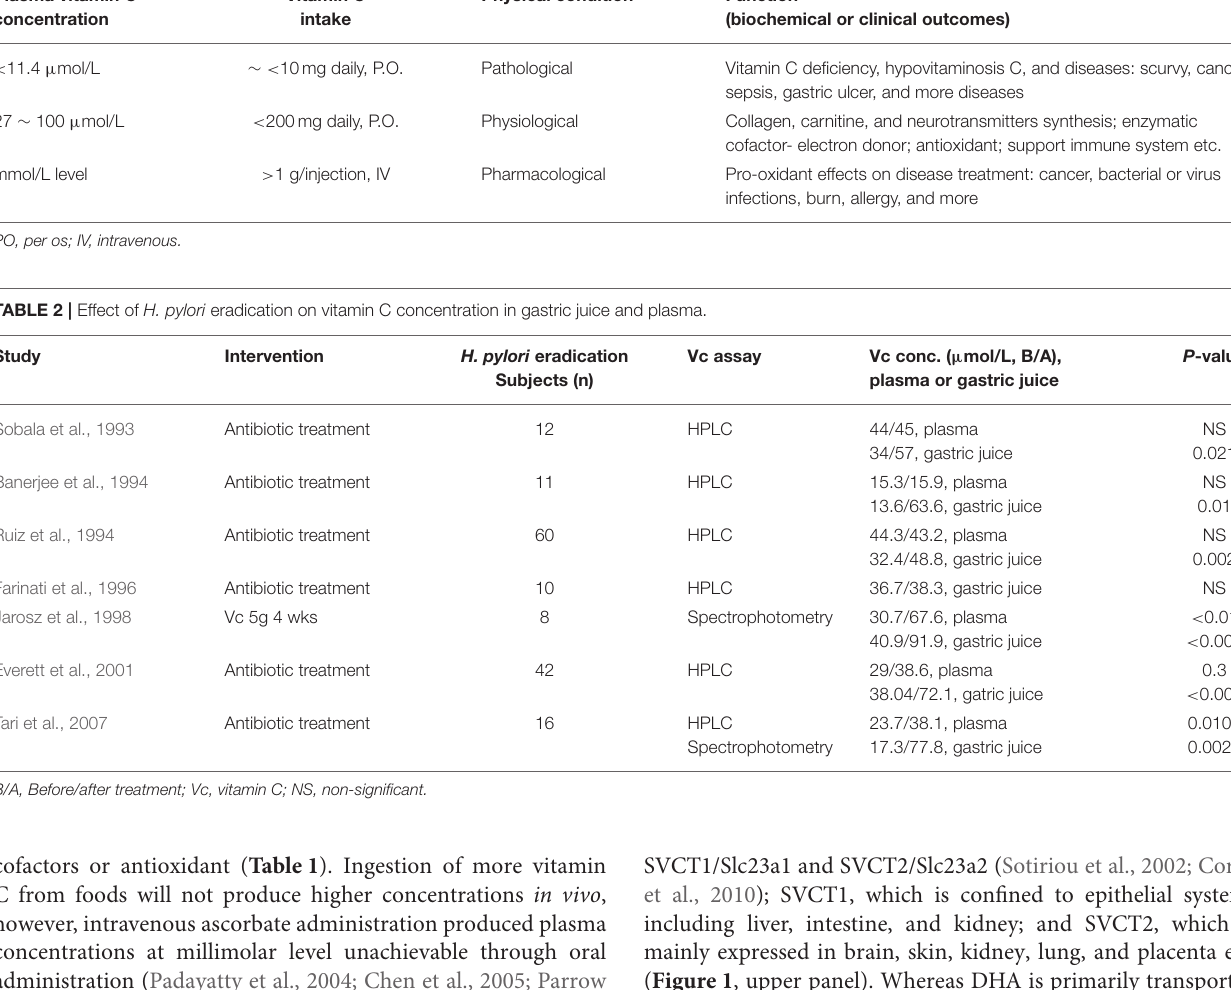
TABLE 1 | Vitamin C concentration-function relationship: Pathology - vitamin C deficiency or low level in diseases; Physiology - normal range of plasma vitamin C level: enzymatic cofactor and antioxidant; Pharmacology - high dose intravenous vitamin C administration: pro-oxidant effects. Plasma vitamin C Vitamin C concentration intake